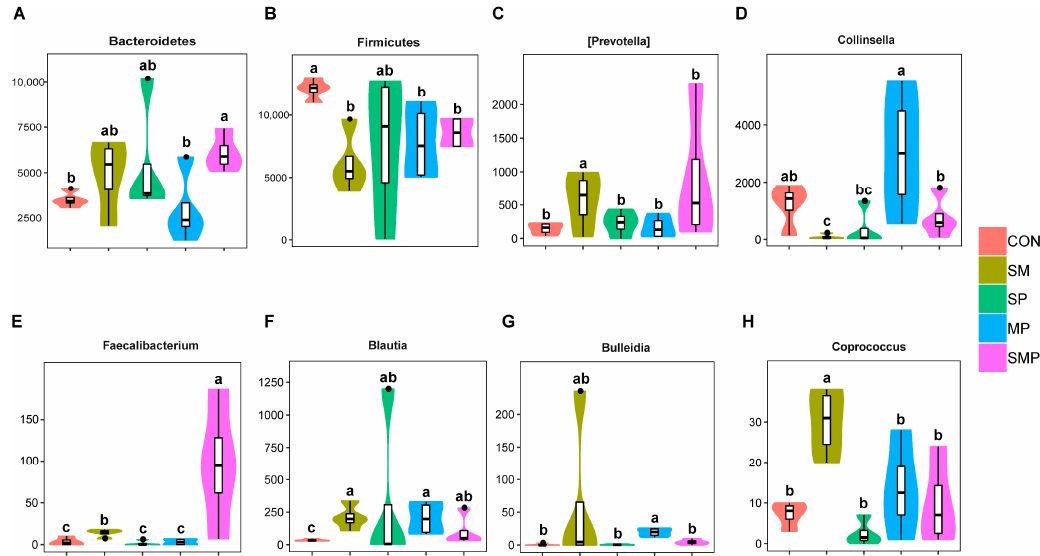
Figure 4. Effects of supplementing the diets with different combinations of SB, MCFAs, and omega − 3 PUFA on specific bacteria in the colonic digesta of suckling piglets. Data are expressed as the means ± SEM ( n = 4). a–c Values within a row with different superscripts differ significantly at p < 0.05. ( A , B ) Significantly different species of the colonic digesta at the phylum level. ( C – H ) Significantly different species of the colonic digesta at the genus level.